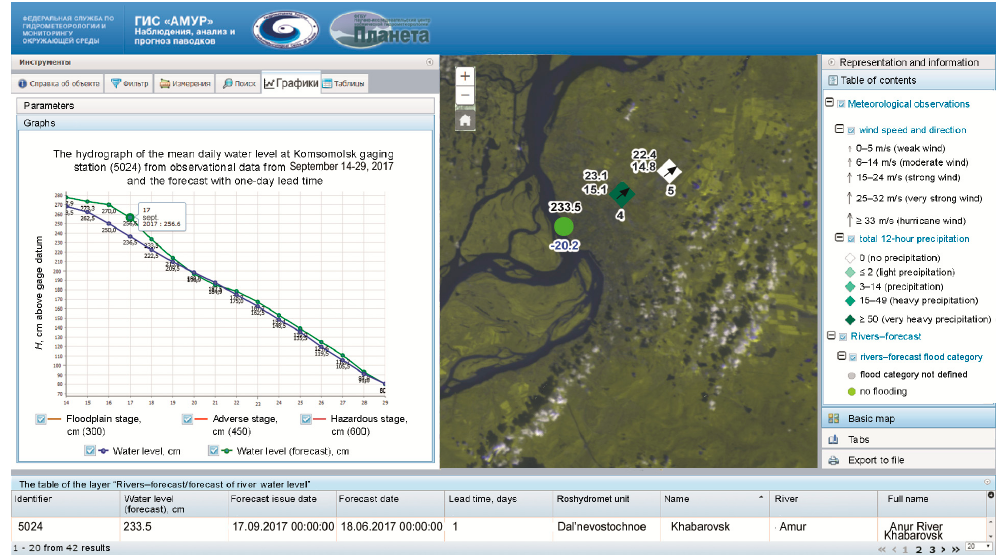
Figure 5. Example of hydrometeorological analysis within the web application (hydrological observations and forecasts and meteorological observations) available for an end-user.